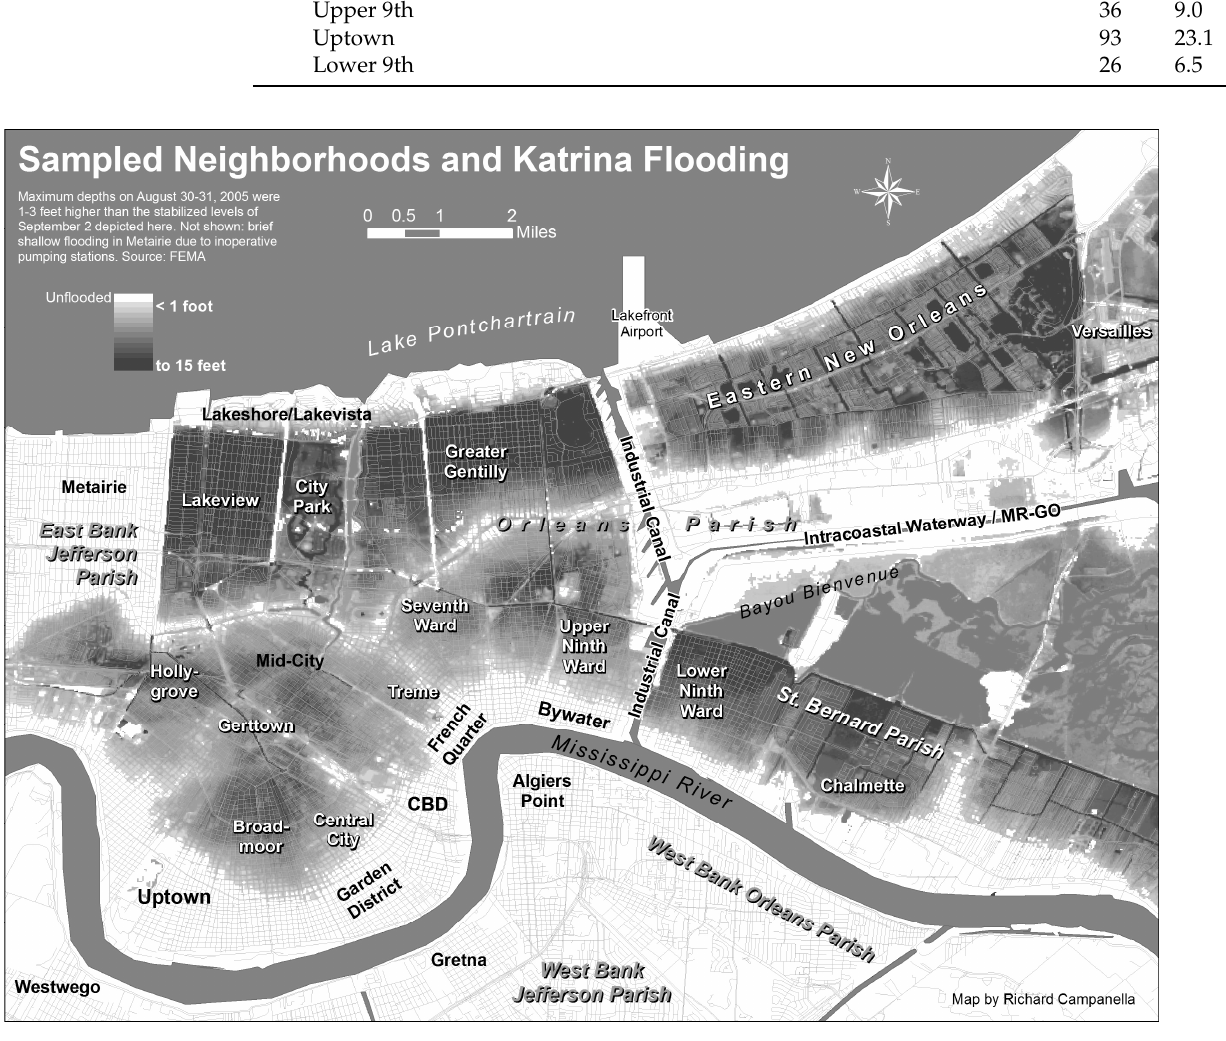
Figure 1. Sampled Neighborhoods in New Orleans, Louisiana. Figure created by Richard Campanella, Tulane University.